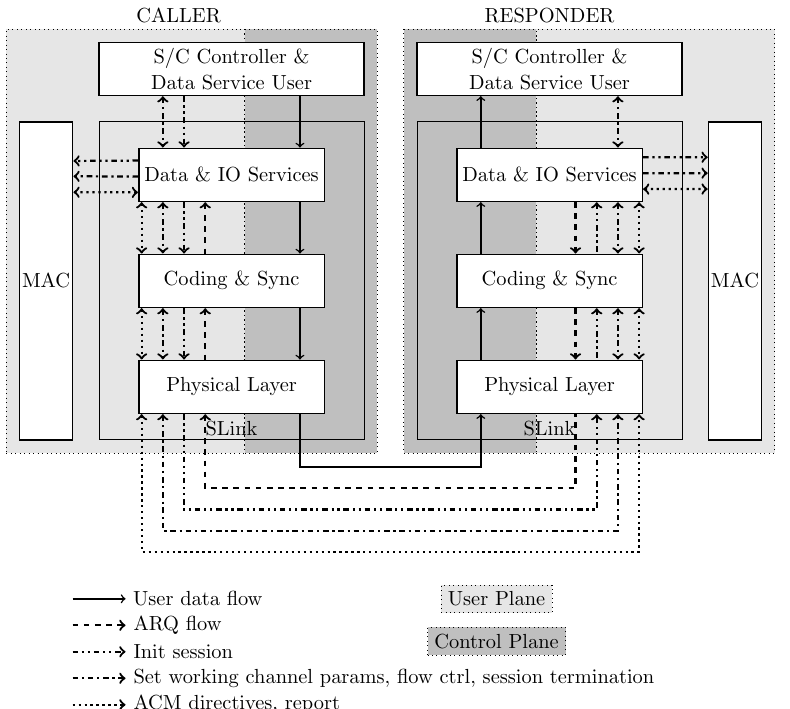
Figure 10. Flow of data and messages between transceiver and